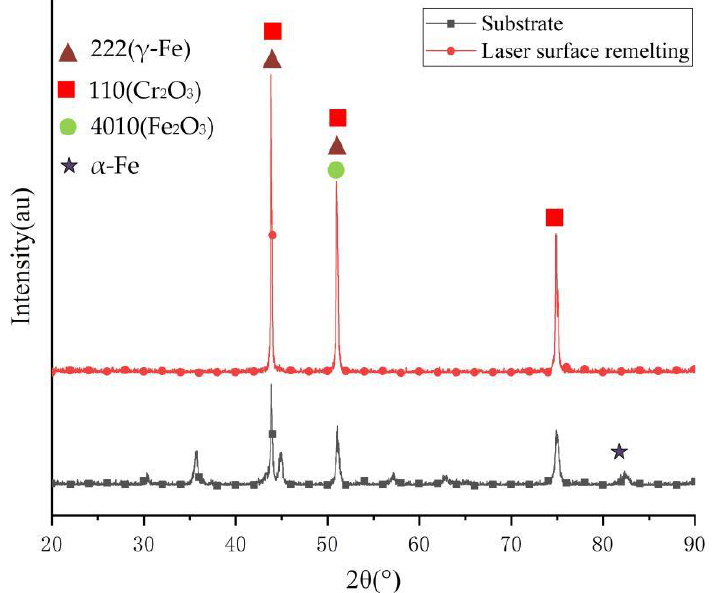
Figure 10. XRD of 304 stainless steel before and after laser surface remelting. Adhesion is the mutual bonding performance between the remelted layer and the substrate and is an important index to measure the performance of the remelted layer. A scratch tester was used to test the adhesion, which is 22.3 N, and the surface morphology after the scratch test is shown in Figure 11.